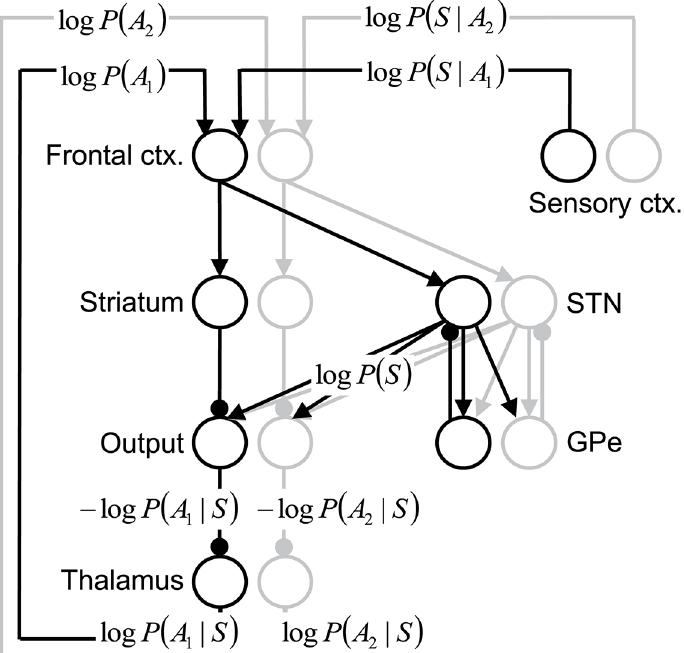
Fig 1. Mapping of Bayes ’ theorem onto a subset of the cortico-basal-ganglia-thalamic circuits. Black and grey circles denote neural populations selective for two sample actions ( A 1 or A 2 ), and the labels next to the circles indicate their anatomical correlates. Arrows denote excitatory (glutamatergic) connections, while lines ended with circles denote inhibitory (GABAergic) connections. The following abbreviations have been used: ctx. – cortex, STN – subthalamic nucleus, GPe – external globus pallidus, Output – output nuclei of the basal ganglia, i.e. internal globus pallidus and substantia nigra pars